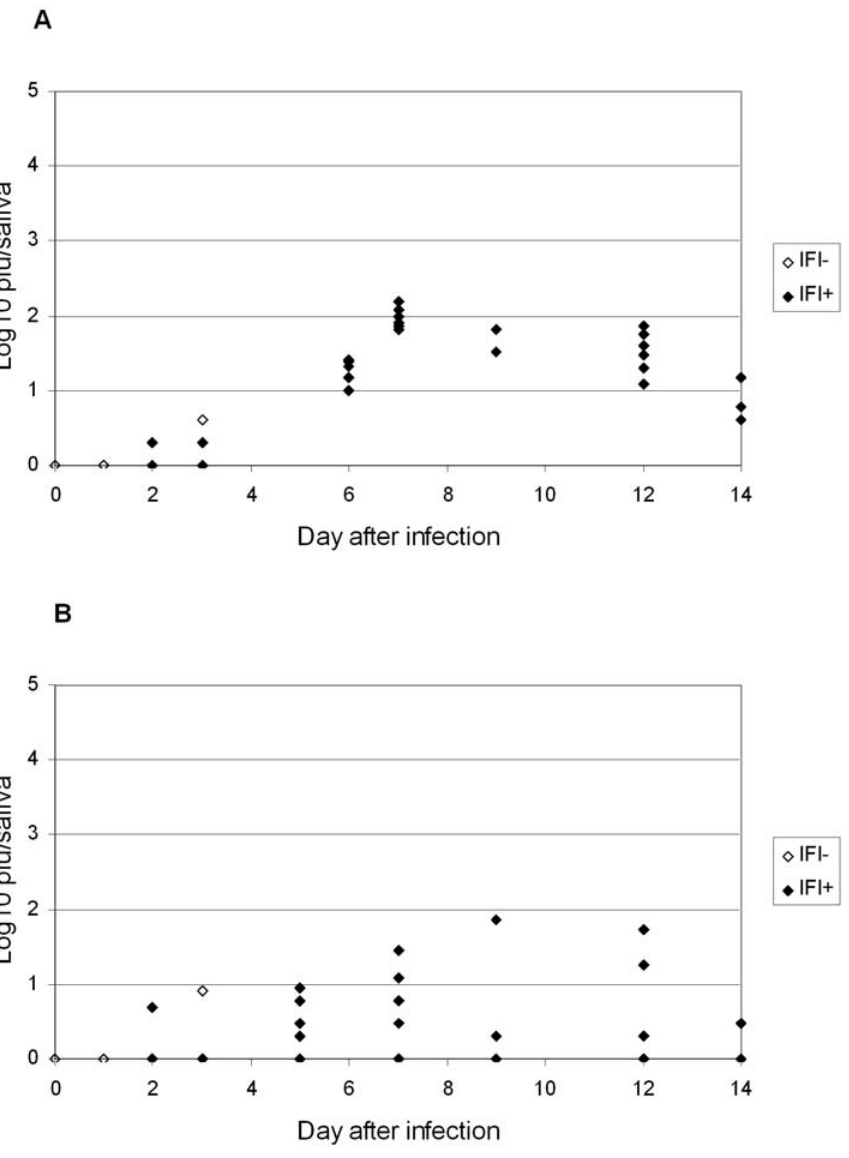
Figure 5. Relation between CHIKV in saliva and IFA-positive head squashes of (A) ALPROV and (B) AAPT. At different days after oral infection, 5 females were tested for the presence of CHIKV on head squashes and the number of infectious viral particles in excreted saliva to evaluate the relation between the presence of CHIKV in saliva and head squashes positive by IFA.